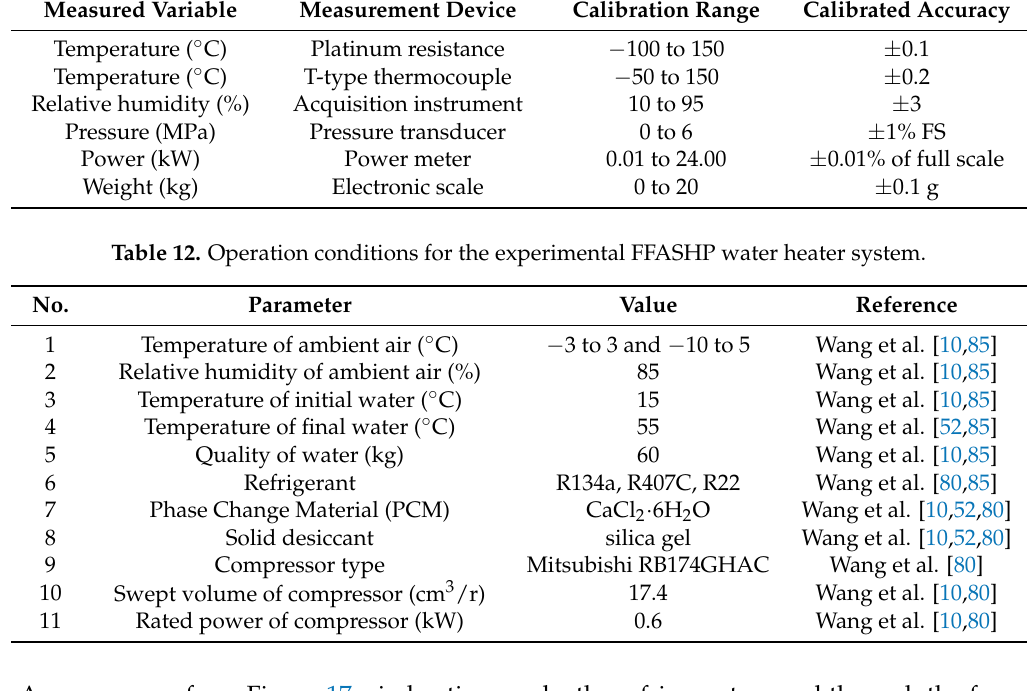
Table 11. Main characteristics of the measuring instrumentation [10,80].